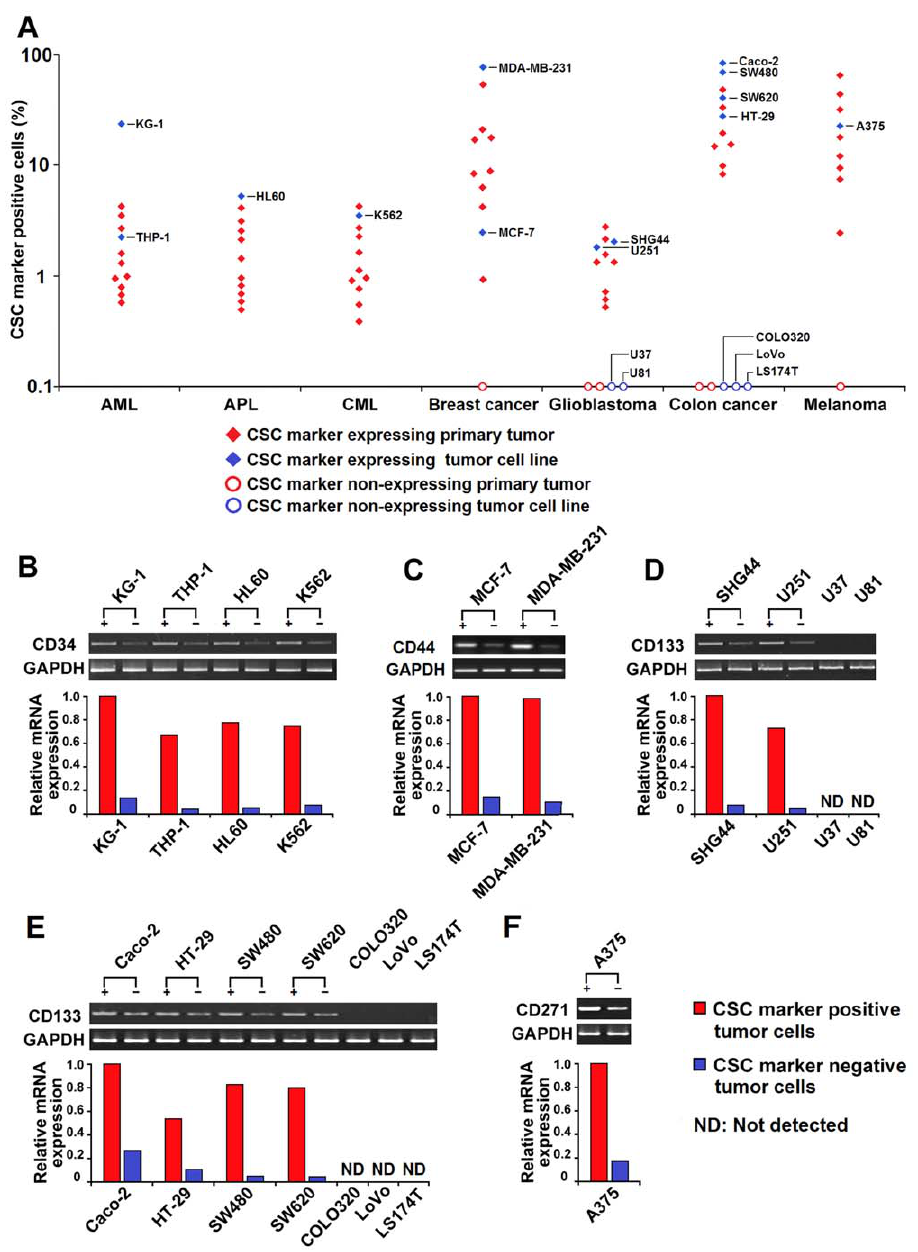
Figure 1. Expression of CSC marker in human primary tumors and tumor cell lines. ( A ) The percentage of CSC marker positive cells from human primary tumors (n=10 for each type) and tumor cell lines. Single cell suspensions were prepared, followed by flow cytometric analysis. Dots represent the percentage of CD34 + CD38 2 cells in AML, APL, and CML, CD44 + CD24 2 cells in breast cancer, CD133 + cells in glioblastoma and colon cancer, and CD271 + cells in melanoma samples. ( B–F ) The CSC marker mRNA expression level of cells (CSC + and CSC 2 cells from CSC marker expressing tumor cell lines, and cells from non-expression tumor cell lines) was analyzed by qRT-PCR and normalized to GAPDH . The level of CD34 mRNA in KG-1 CSC + cells, CD44 mRNA in MCF-7 CSC + cells, CD133 mRNA in SHG-44 and Caco-2 CSC + cells, CD271 mRNA in A375 CSC + cells, was arbitrarily designated as 1.0 for leukemia, breast cancer, glioblastoma, colon cancer, melanoma samples, respectively. Photographs show the RT-PCR products and histograms show the CSC marker mRNA expression level of cells from leukemia ( B ), breast cancer ( C ), glioblastoma ( D ), colon cancer ( E ), and melanoma ( F ) cell lines. Note that cells from CSC marker non-expressing tumor cell lines (U37, U81, COLO320, LoVo, LS174T) do not express CSC marker mRNA. population were indeed progenies of CSC 2 cells and not a result and Figure S2, both CSC + and CSC 2 cells were capable of of cell contamination introduced during cell sorting [40], we generating single cell-derived sublines and giving rise to the two measured (in CSC marker expressing tumor cell lines, using flow subsets. Initially, the percentage of CSC marker positive cells in cytometry) the percentage of CSC marker positive cells in single single CSC 2 -derived sublines was significantly lower than in single CSC + -derived or CSC 2 -derived sublines. As shown in Figure 4 CSC + -derived sublines. However, over an extended period of